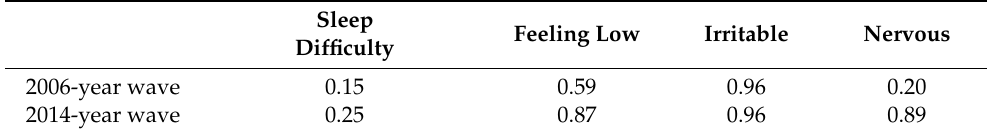
Table 2. The strength centrality analysis demonstrating the link between adolescents’ excessive electronic device use and emotional symptoms and sleep difficulty